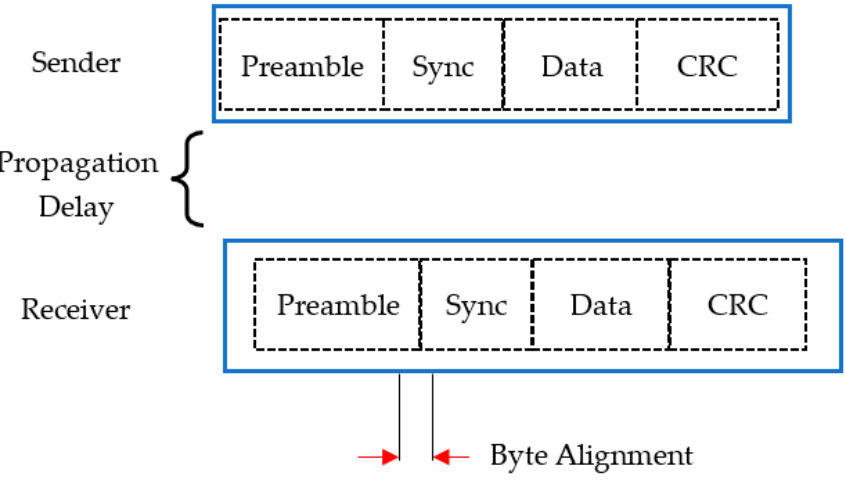
Figure 9. FTSP broadcast message.